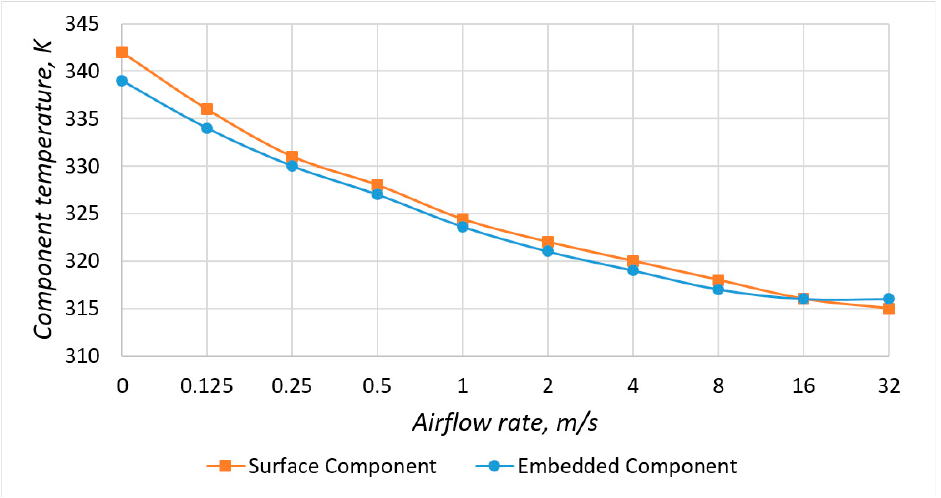
Figure 10. Heat distribution according to models with a copper layer under natural convection conditions: ( a ) surface component; ( b ) embedded component.